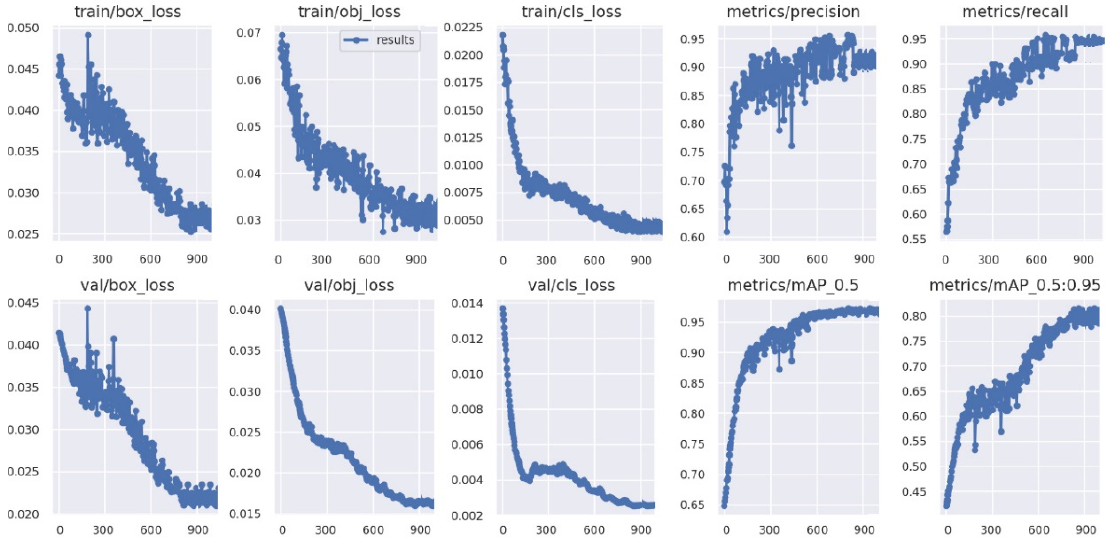
Figure 12. Visual analysis of model evaluation indicators during training (model iterations 0–1000 times).